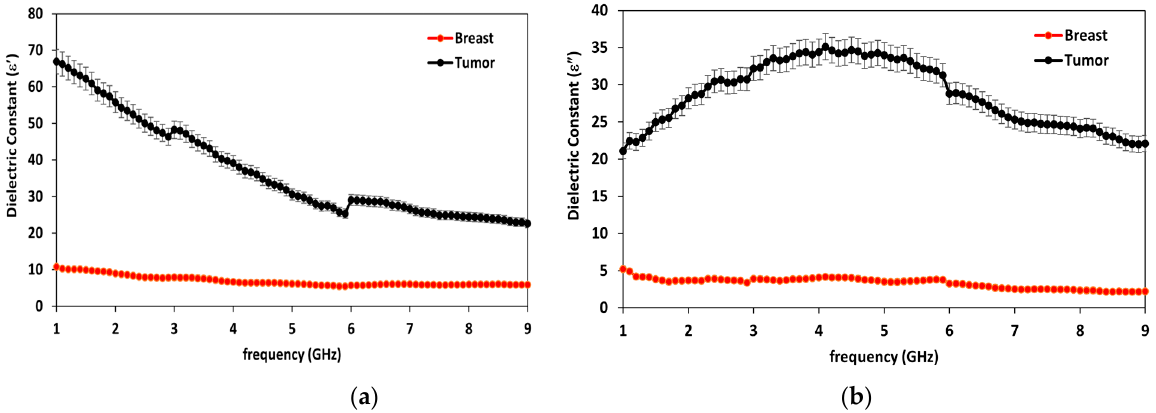
Figure 4. Measured electrical properties of breast phantom and tumor models versus frequency: ( a ) real part of dielectric constant ( ε′ ) and ( b ) imaginary part of dielectric constant ( ε″ ).